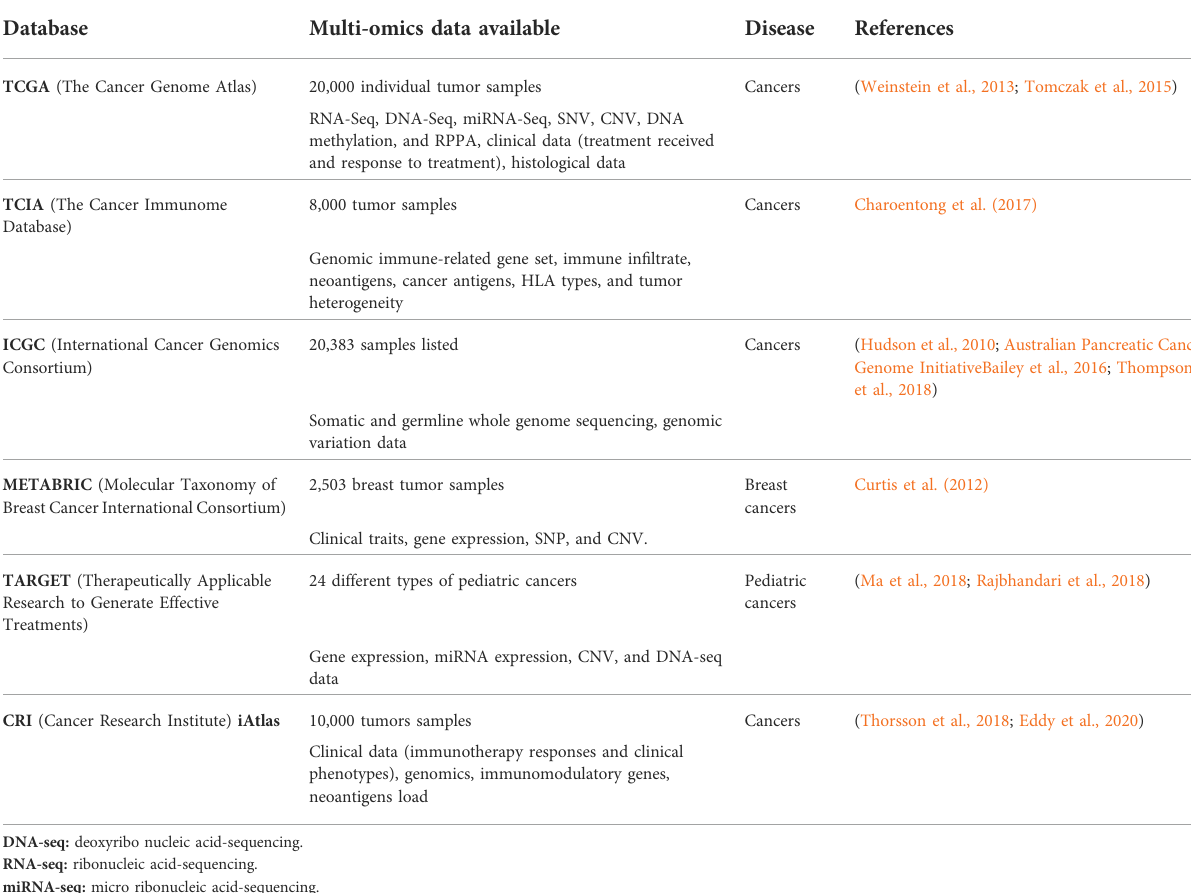
TABLE 2 Publicly available cancer databases with their main